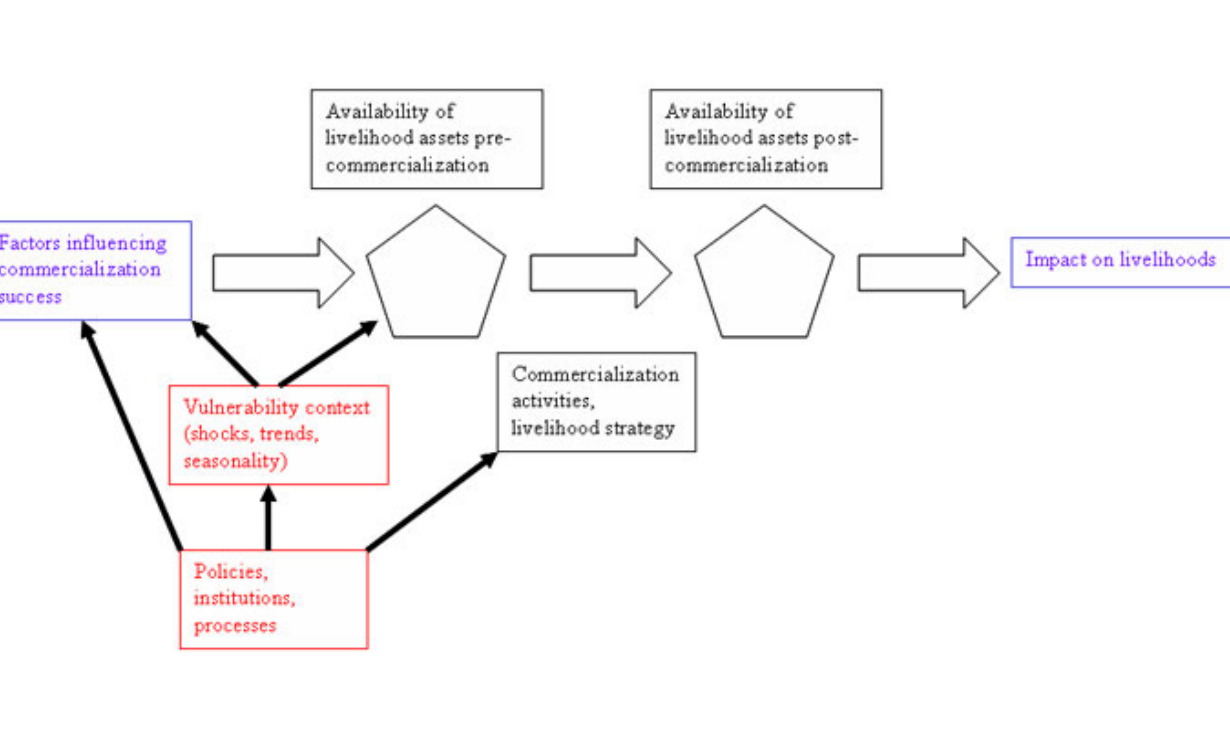
Fig. A7.5. Expanded analytical framework for assessing the impact of policy interventions on NTFP commercialization processes and on livelihoods. We propose that policy interventions mediated through appropriate institutions and processes will influence both the factors influencing commercialization and the process of NTFP commercialization itself, as well as alternative livelihood strategies. Policy context will also influence the vulnerability context of actors involved in commercialization, reflecting the impact of external shocks, market trends, seasonal variation, etc. The impact of policy interventions on livelihoods is determined by their impact on availability of the five types of asset before and after